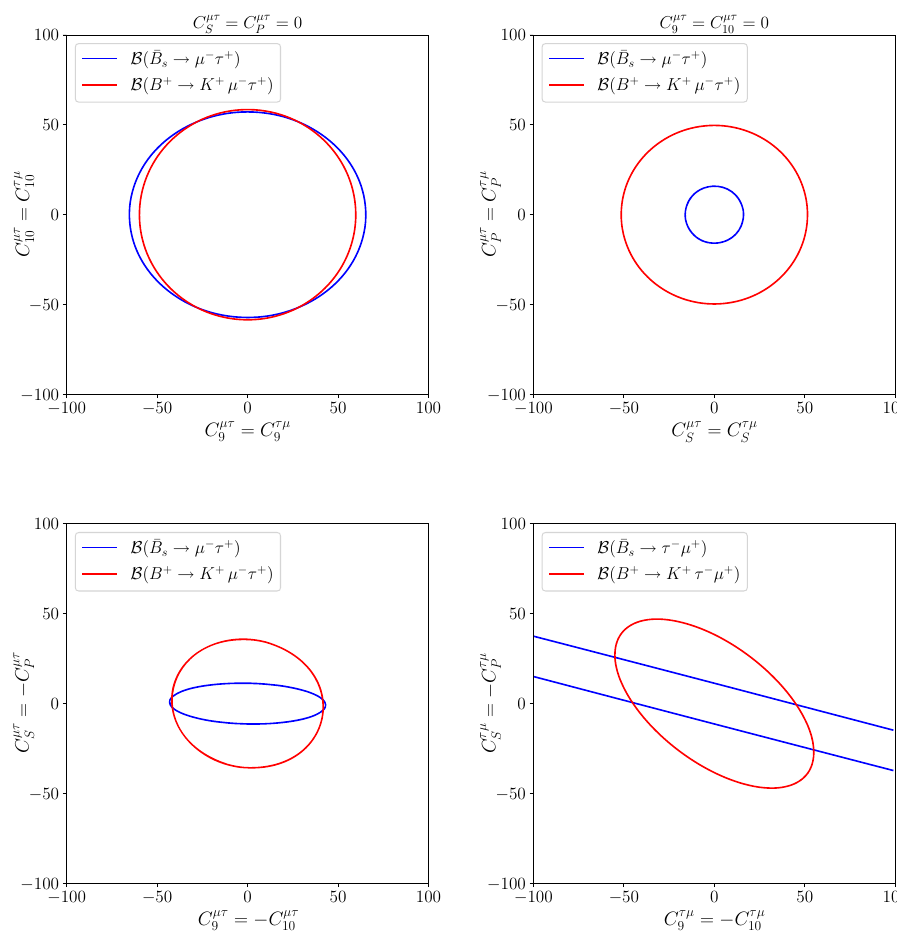
Fig. 1 Model independent constrains on different combinations of Wilson coefficients obtained from the 90% CL upper limits on meson b → s μ ± τ ∓ transitions Both Eqs. (19) and (20) agree with previous results in the lit- erature [91,92]. Using again the values for the masses from PDG [73], CKM factors from the UT-fit collaboration [80], = 215 MeV [93] and Lattice QCD/Light Cone Sum f B s Rule results in Refs. [89,90], we find the coefficients c i (cid:3) in Eq. (20) as listed in Table 4. Similar as for ξ 9 S , the